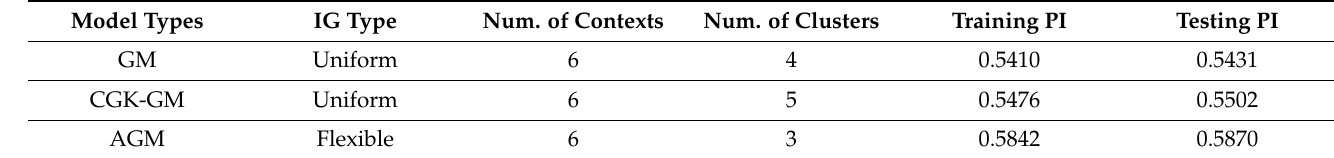
Table 8. Experimental Results of Predicting Boston Home